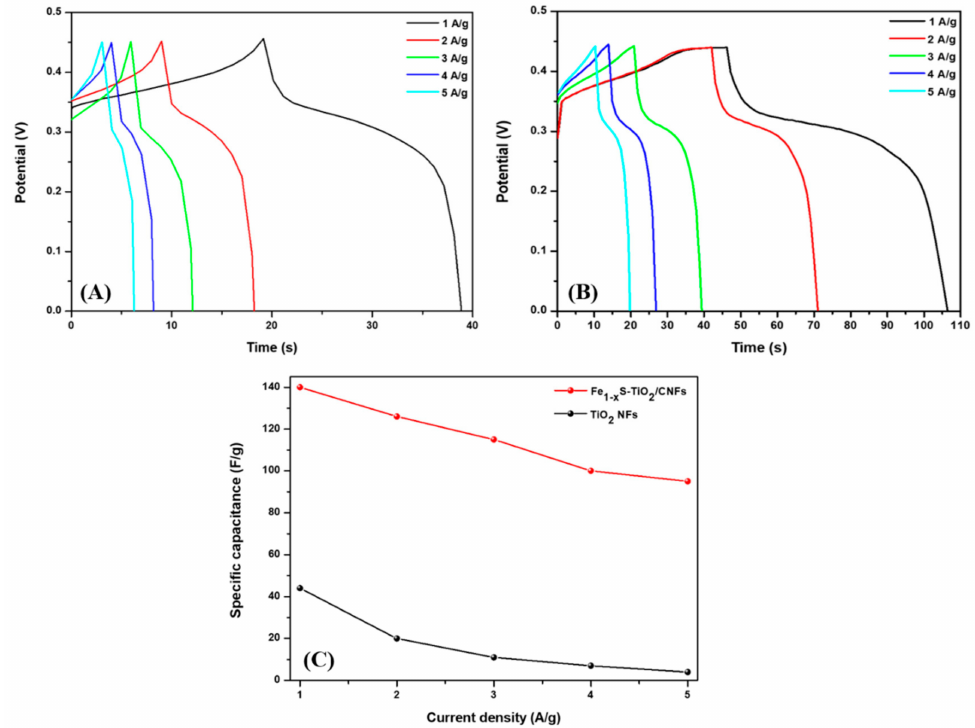
Figure 7. Galvanostatic charge–discharge (GCD) curves of TiO 2 NFs ( A ) and Fe 1 − x S-TiO 2 / CNFs composite ( B ). ( C ) represents the specific capacitance of Fe 1 − x S-TiO 2 / CNFs composite electrode as compared to TiO 2 NFs at various current